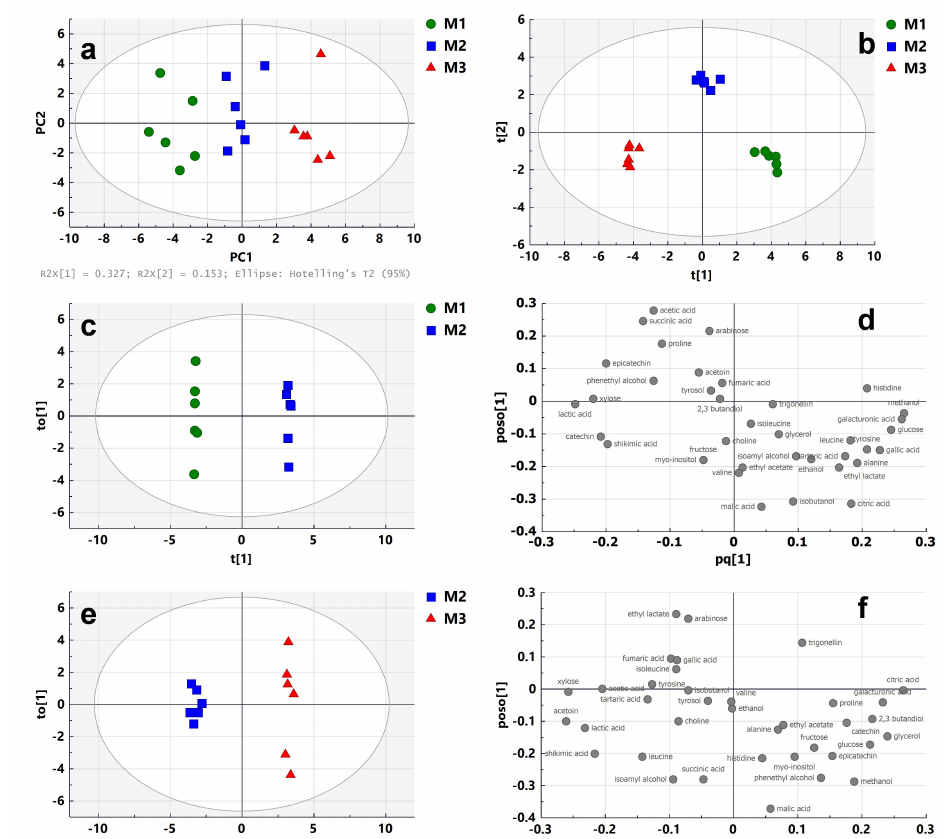
Figure 2. Multivariate analysis of 1 H-NMR spectra of wine samples from grapes harvested at three different stages of maturity (M1: under-maturity; M2: maturity; M3: over-maturity): ( a ) PCA score plot; ( b ) OPLS-DA score plot; ( c ) OPLS-DA score showing separation of M1 and M2 samples; ( d ) loadings from OPLS-DA between M1 and M2 samples; ( e ) OPLS-DA score showing separation of M2 and M3 samples; ( f ) loadings from OPLS-DA between M2 and M3 samples (t[1] and to[1]: first predictive and orthogonal components; t[2]: second predictive component; pq[1] and poso[1]: predictive and orthogonal component